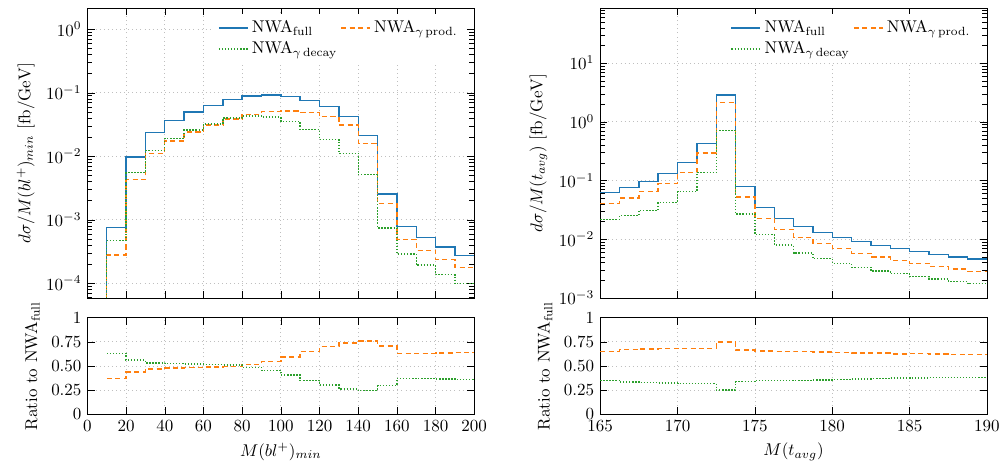
Figure 10 . The pp e + (cid:23) e (cid:22) (cid:0) (cid:22) (cid:23) (cid:22) b (cid:22) b(cid:13) di(cid:11)erential cross section distribution as a function of the ! minimum invariant mass of the positron and b -jet, M ( b‘ + ) min , and the (averaged) invariant mass of the reconstructed top quark, M ( t avg ), at the LHC run II with p s = 13 TeV. The upper plots show absolute NLO QCD predictions in the full NWA together with fraction of events originating from photon radiation in the production, NWA (cid:13) prod , and in decays, NWA (cid:13) decay . The ratios of these contributions to the full NWA result are also shown. Results are given for (cid:22) 0 = H T = 4 and the CT14 PDF sets are